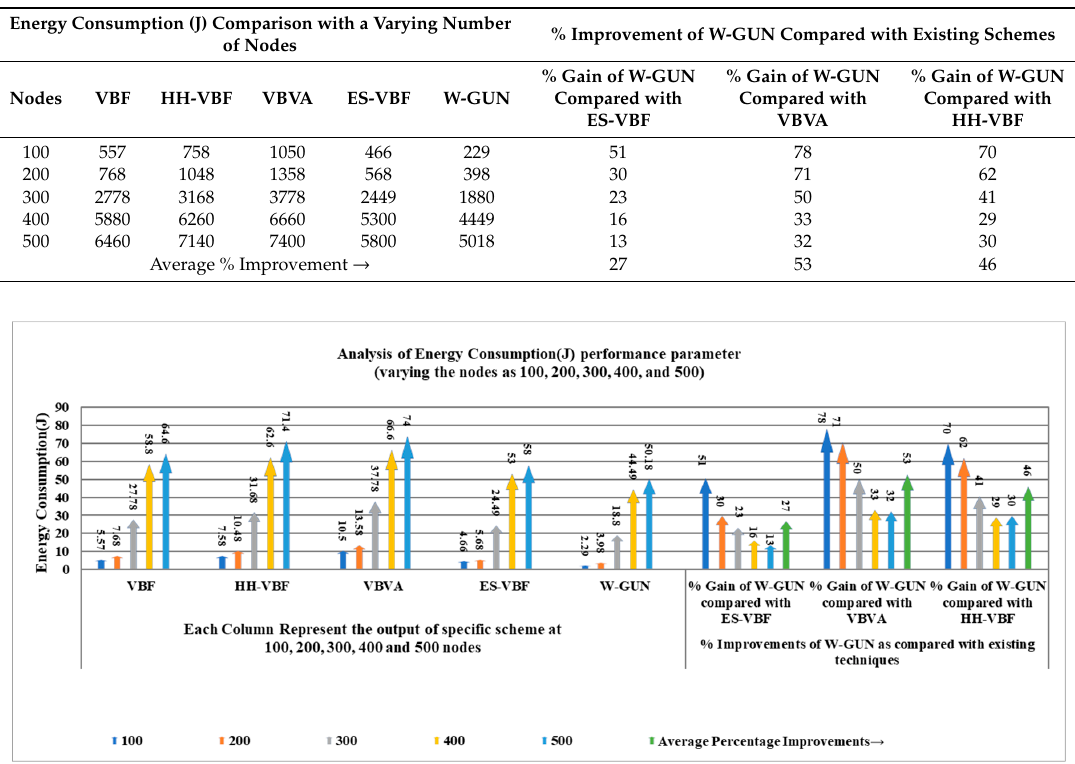
Figure 7. Energy consumption versus the number of underwater nodes. Table 3. Descriptive performance observation of W-GUN in terms of energy consumption.